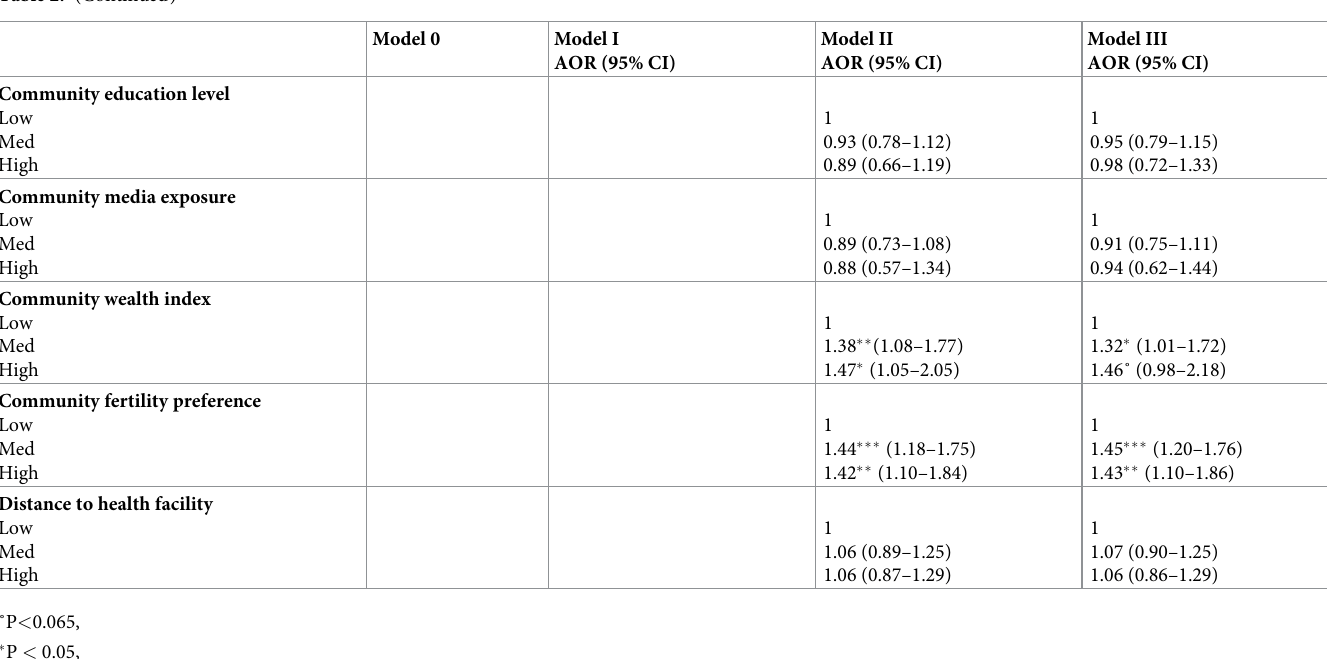
The final model generally generates the same patterns, except for a few changes. Age and sex household head show similar results, but number of living children generates more signifi- cant differences in model III, with higher odds for women with one to two children (aOR = 2.46, CI: 1.81–3.35), women with three to six children (aOR = 3.32, CI: 2.37–4.66), and women with seven or more children (aOR = 6.46, CI: 4.28–9.73). On the community level, all provinces have slightly lower odds of having unmet need for family planning compared to the preceding model. The odds for the provinces Equateur (aOR = 1.82, CI: 1.24–2.68), Nord- Kivu (aOR = 1.66, CI: 1.10–2.55) and Orientale (aOR = 1.60, CI: 1.10–2.32) remained signifi- cant, while Bandundu and Maniema did not show significant results anymore. Community wealth and community fertility preference showed similar results in both models. Except for religion, all other variables without a significant correlation do not show notable results in model III. Their odds range between 0.90 and 1.07, hence do not have a strong effect